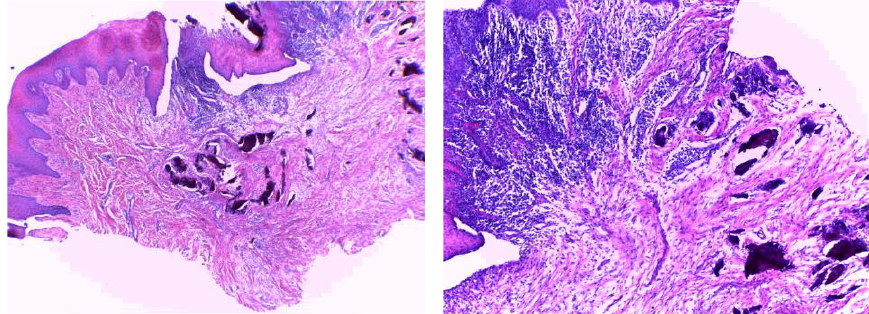
Figure 3. Histopathological examination of the CHX group.